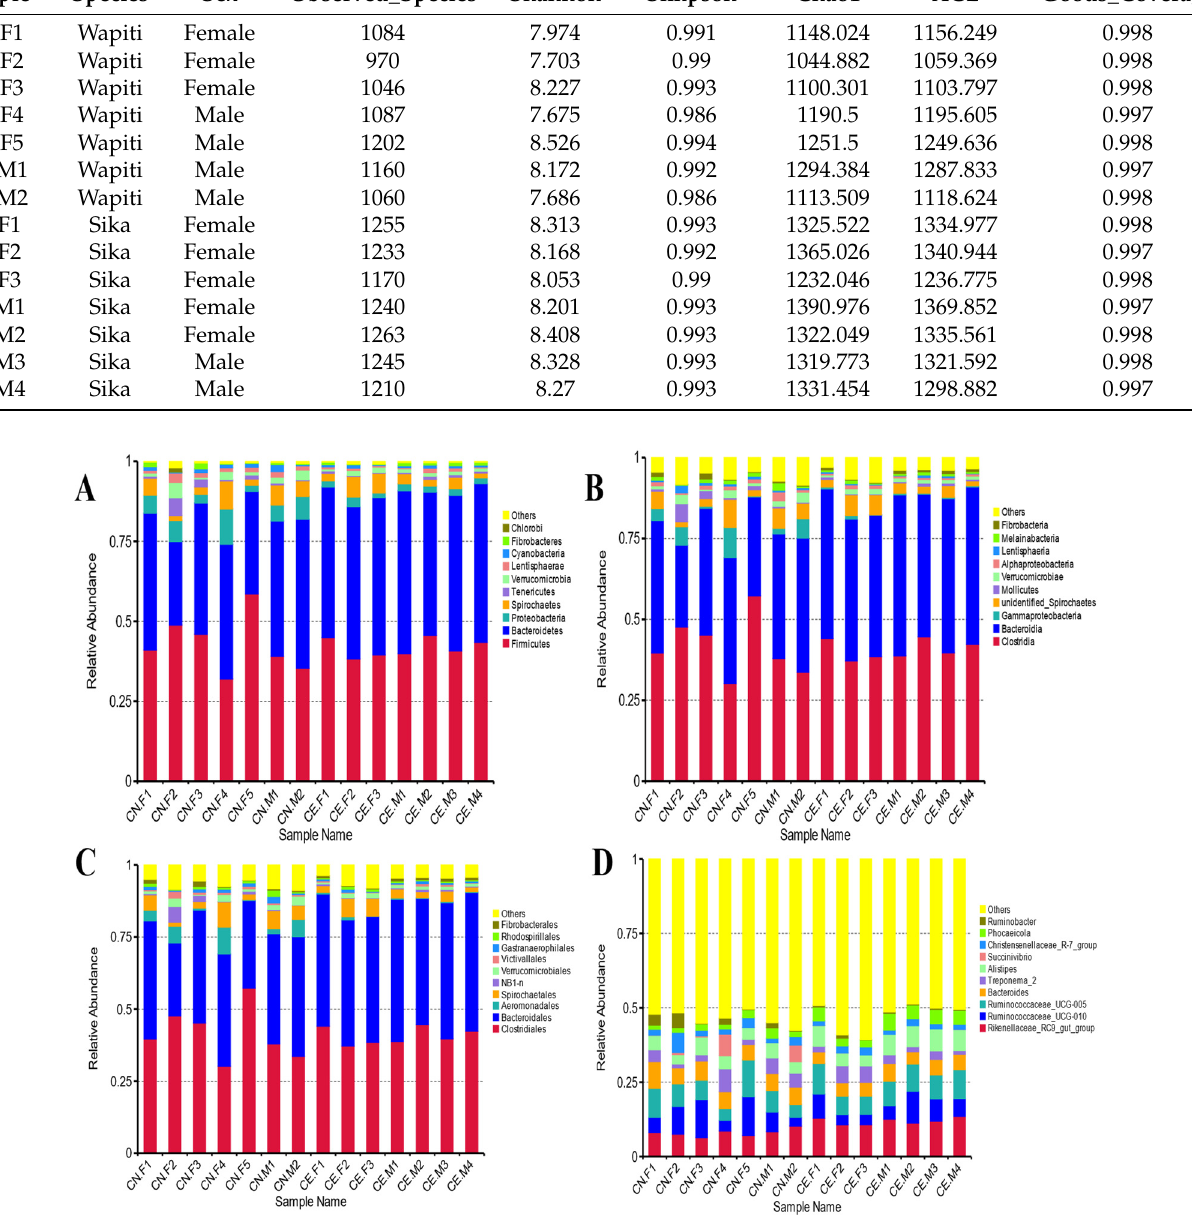
Figure 2. Bar plot of relative abundance. ( A ) Taxonomic level of phylum. ( B ) Taxonomic level of class. ( C ) Taxonomic level of order. ( D ) Taxonomic level of genus. Each bar represents the top ten bacterial species ranked by the relative abundance in each individual sample.